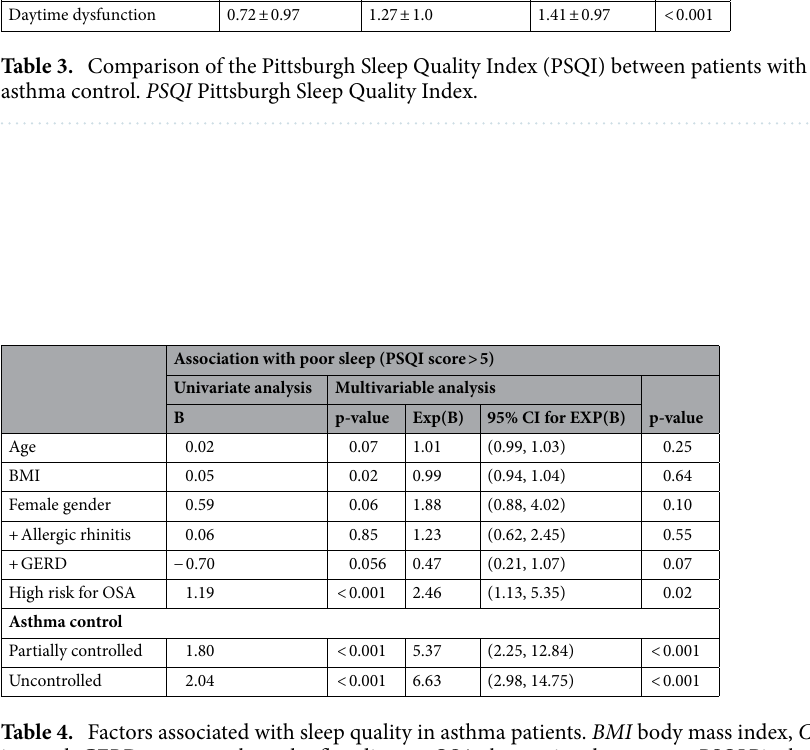
Table 4. Factors associated with sleep quality in asthma patients. BMI body mass index, CI confidence interval, GERD gastroesophageal reflux disease, OSA obstructive sleep apnea, PSQI Pittsburgh Sleep Quality